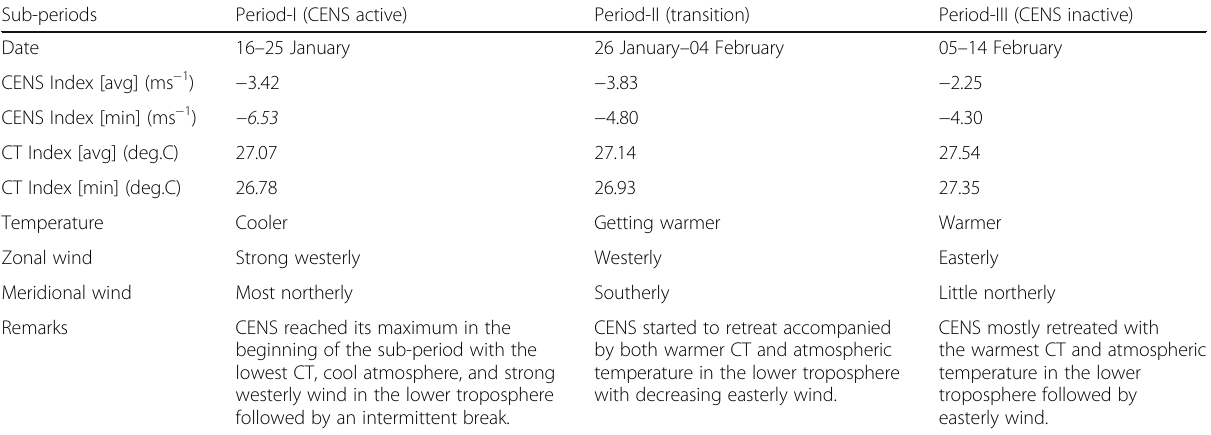
Table 3 Indices and brief descriptions of lower troposphere in each sub-period